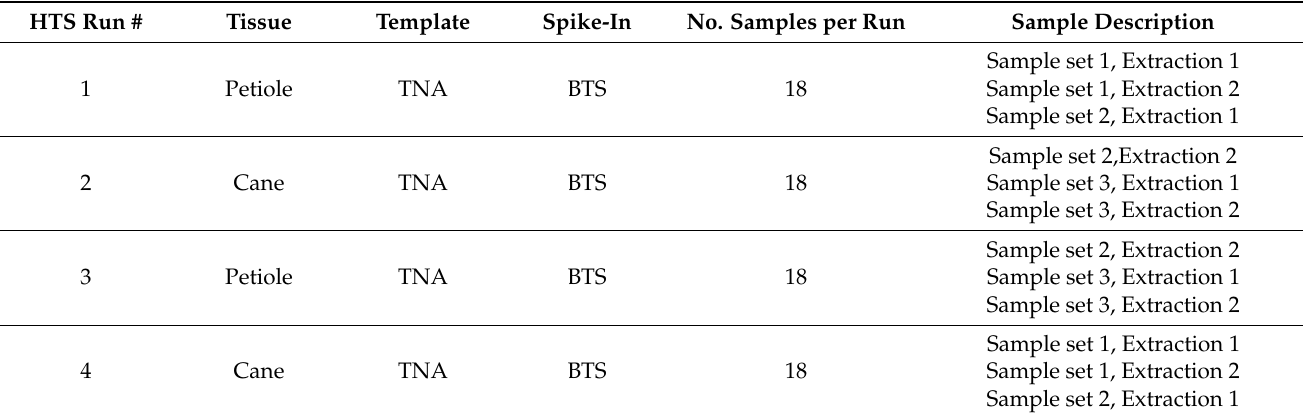
Table 3. Description of the dilution series HTS runs. Three sample sets were divided into four runs. Each sample set consists of extracts from undiluted virus-infected spring petioles and fall canes and their corresponding dilutions of 20%, 10%, 5%, 2%, and 1%. All extractions were prepared in replicate for a total of 24 samples within each sample set. Sample set 1 = vine 7; sample set 2 = vine 9; sample set 3 = vine